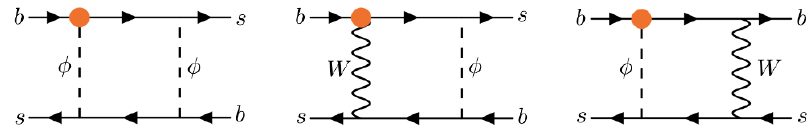
Figure 6 . Diagrams generating contributions to B s mixing from the Q (3) related to these by symmetry, as well as diagrams in which the operator connects to an s quark leg rather than a b quark leg, should be taken to be included.